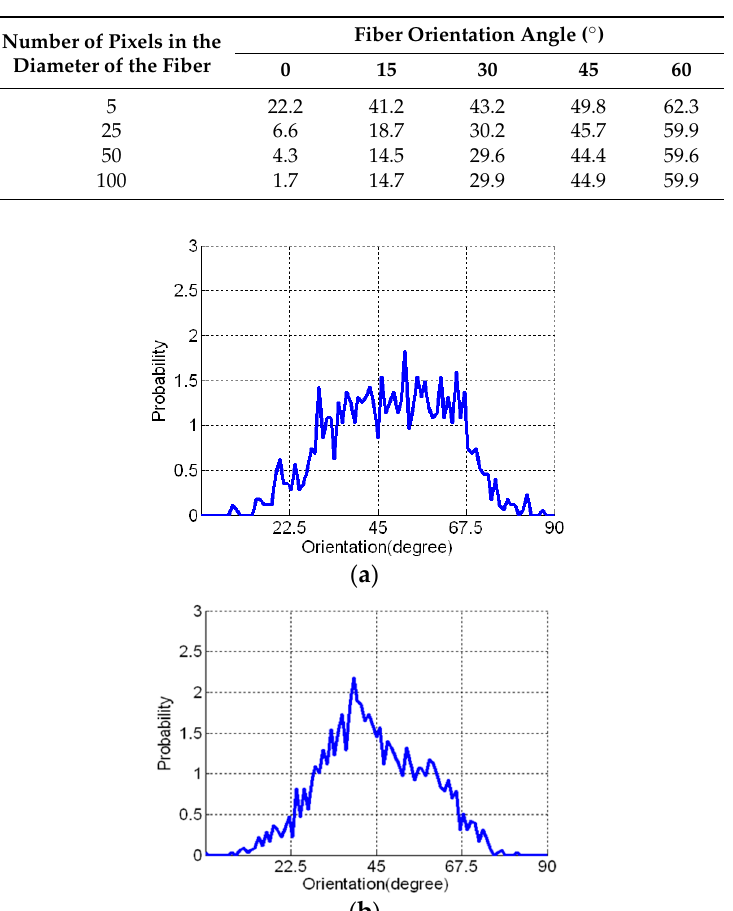
Table 5. Measured orientation angle of the artificial fiber image according to the number of pixels in the diameter [40].